Question: Briefly state, in one sentence, what is plotted here.
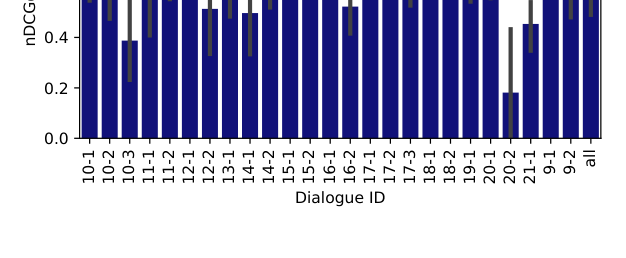
Answer: nDCG@3 on PTKB relevance prediction, aggregated for each topic across all runs. We report the average across runs, median or better.